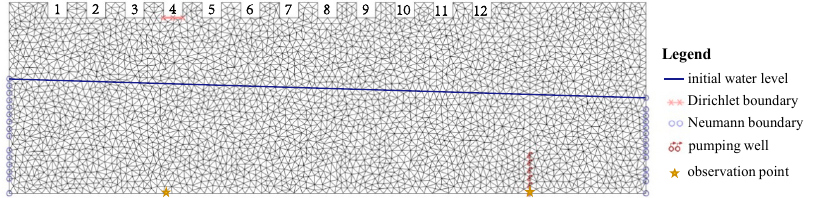
Figure 8. Initial conditions of simulation model.